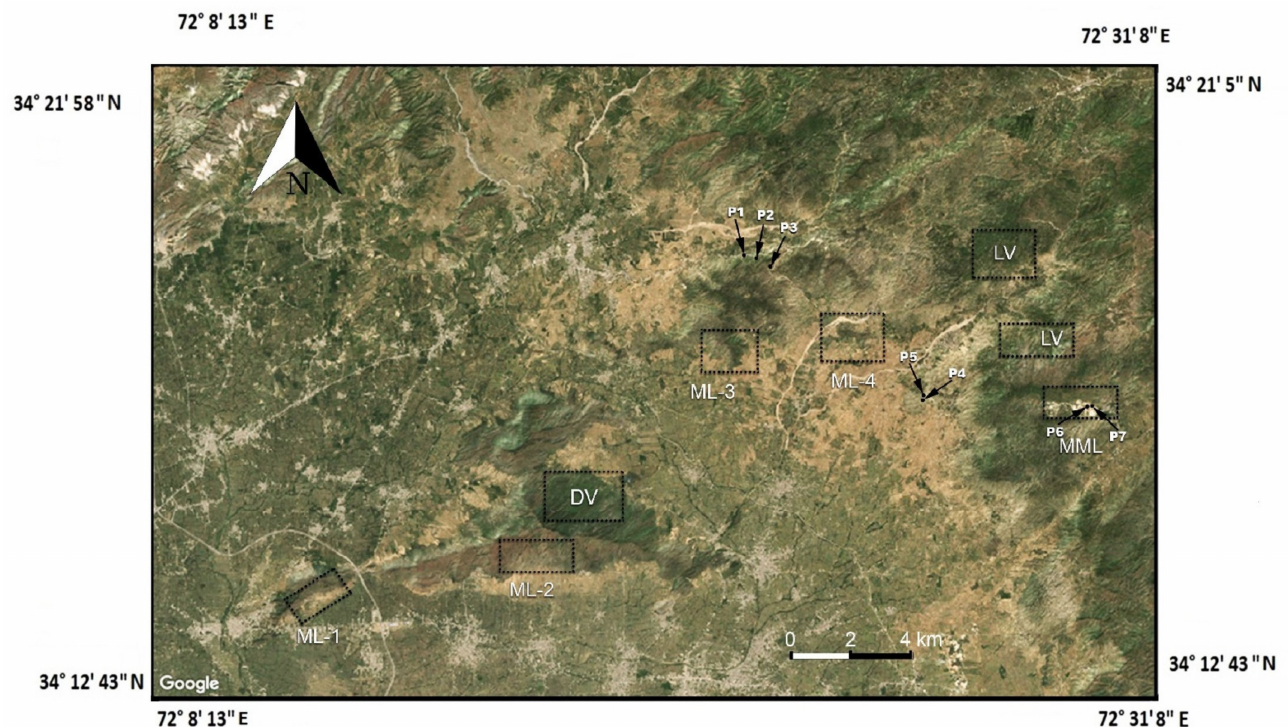
Figure 2. Locations of granite leases (ML-1 and ML-2) at Shewa Shahbazghari, granite leases (ML-3 and ML-4), and marble mining leases (MMLs) at Ambela Complex. The regions of dense vegetation (DV) and light vegetation (LV) are overlaid on the Sentinel-2 Multispectral Instrument (MSI) mosaicked image. Seven points P1–P7 show different validation points during the field